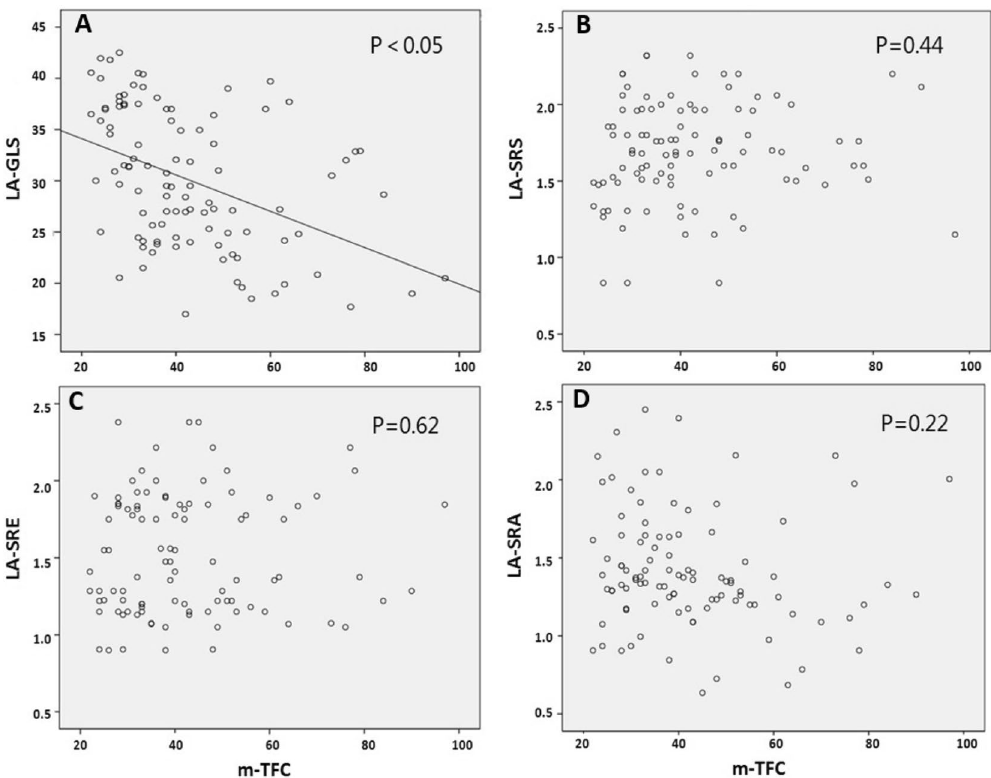
Figure 2. ( A ) LA-GLS and mTFC correlation test; ( B ) LA-SRS and mTFC correlation test; ( C ) LA-SRE and mTFC correlation test; ( D ) LA-SRA and mTFC correlation test. LA-GLS left atrial global longitudinal strain, LA-SRS left atrial longitudinal strain rate (systolic), LA-SRE left atrial longitudinal strain rate (early diastolic), LA-SRA left atrial longitudinal strain rate (late diastolic), mTFC average of TIMI frame